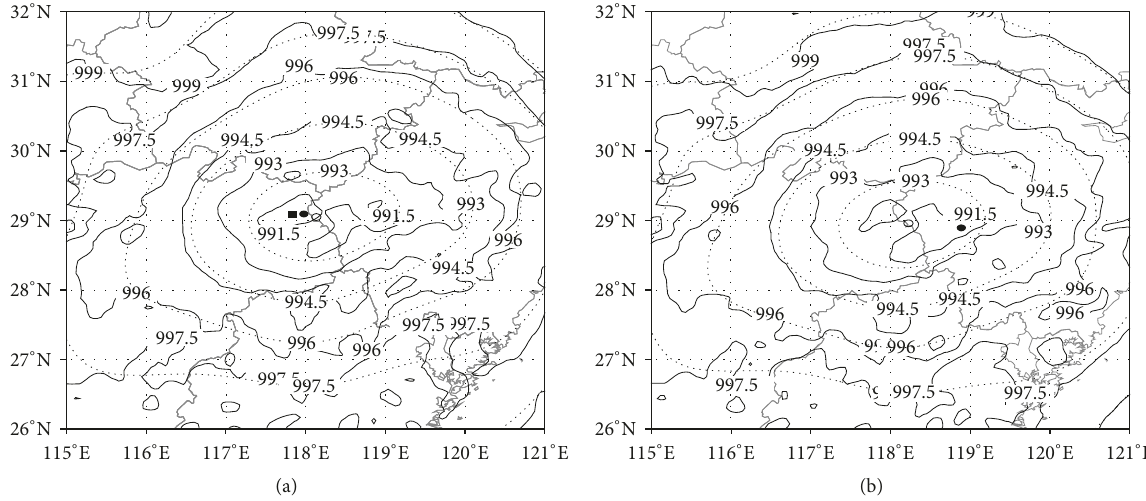
Figure 6: The simulated SLP (unit hPa) field with Barnes filter (dotted lines) and without Barnes filter (solid lines) for (a) 0600 UTC and (b) 0500 UTC 24 July 2014 after TC Matmo landed China. Open (filled) circle indicates the TC center determined by SLP with (without) Barnes filter. Filled square represents the observed TC